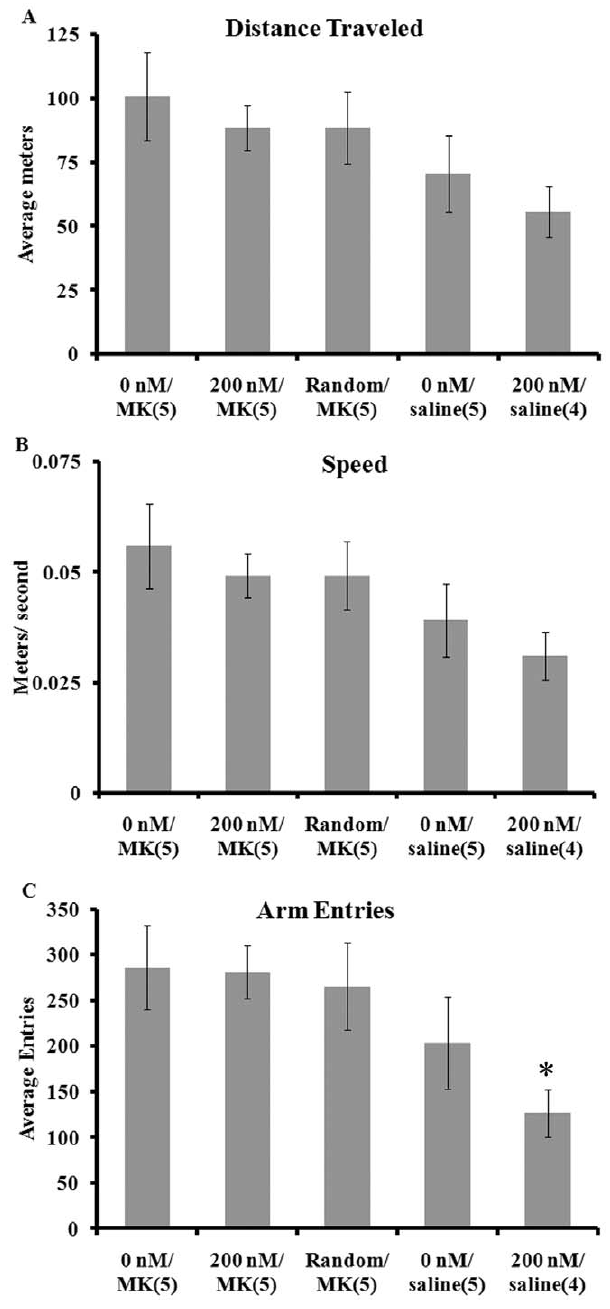
Figure 3. Horizontal activity was not affected by intra- accumbens injection of the aptamer. Locomotor activity was assessed in an elevated cross maze for 30 min. Activity was measured as total distance in meters traveled (A), average speed in meters/ sec (B) and total arm entries (C). No main effect of group was detected. Arm entries in all MK-801-injected groups (0 nM/ MK, 200 nM/ MK and Random/ MK; n=5 per group) were significantly different from the 200 nM/ saline-treated group (n=5) (*, p , 0.05). The saline treated groups were not significantly different on any measure of activity. Data are expressed as mean 6